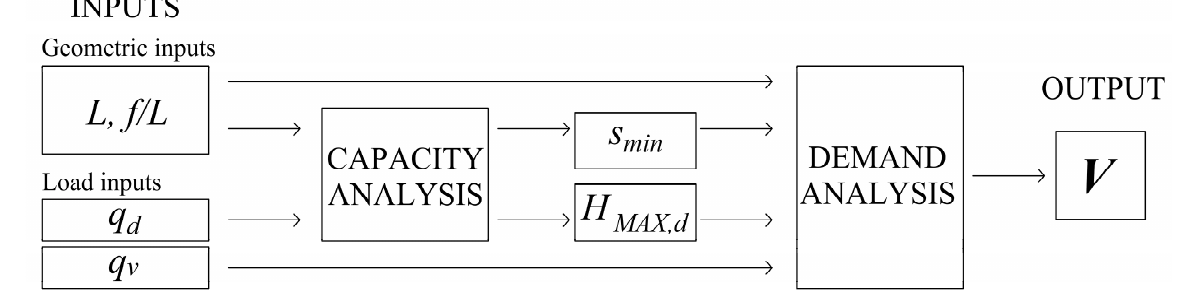
Figure 2. Scheme of the